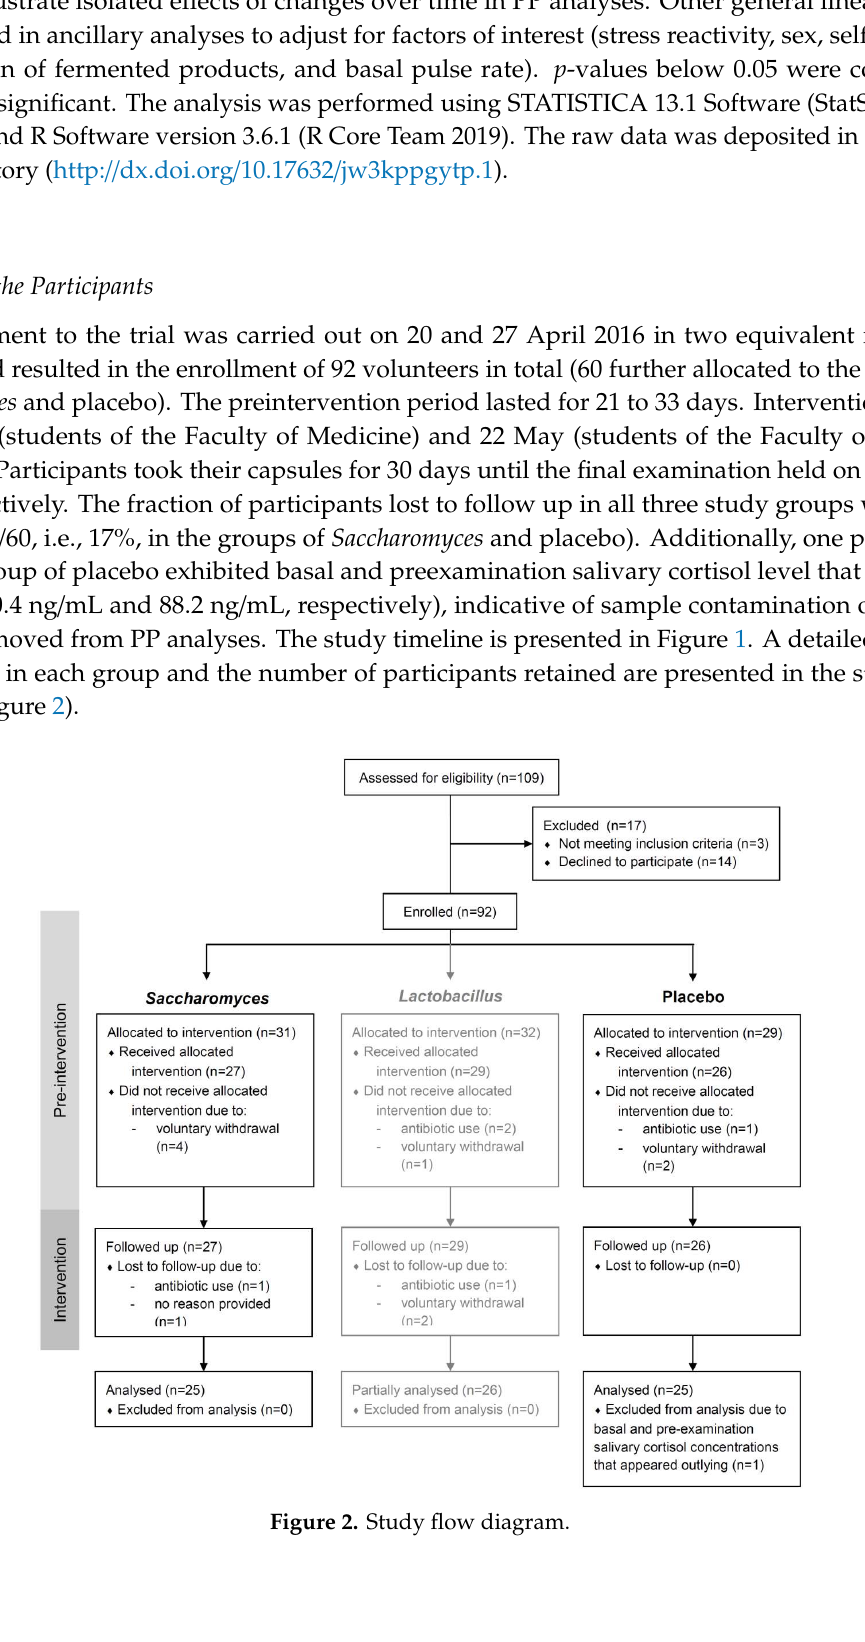
Table 1. Basal sociodemographic, psychometric, and laboratory characteristics of the participants enrolled to the study: The results include means and standard deviations or absolute and relative frequencies, if not stated otherwise. Variable